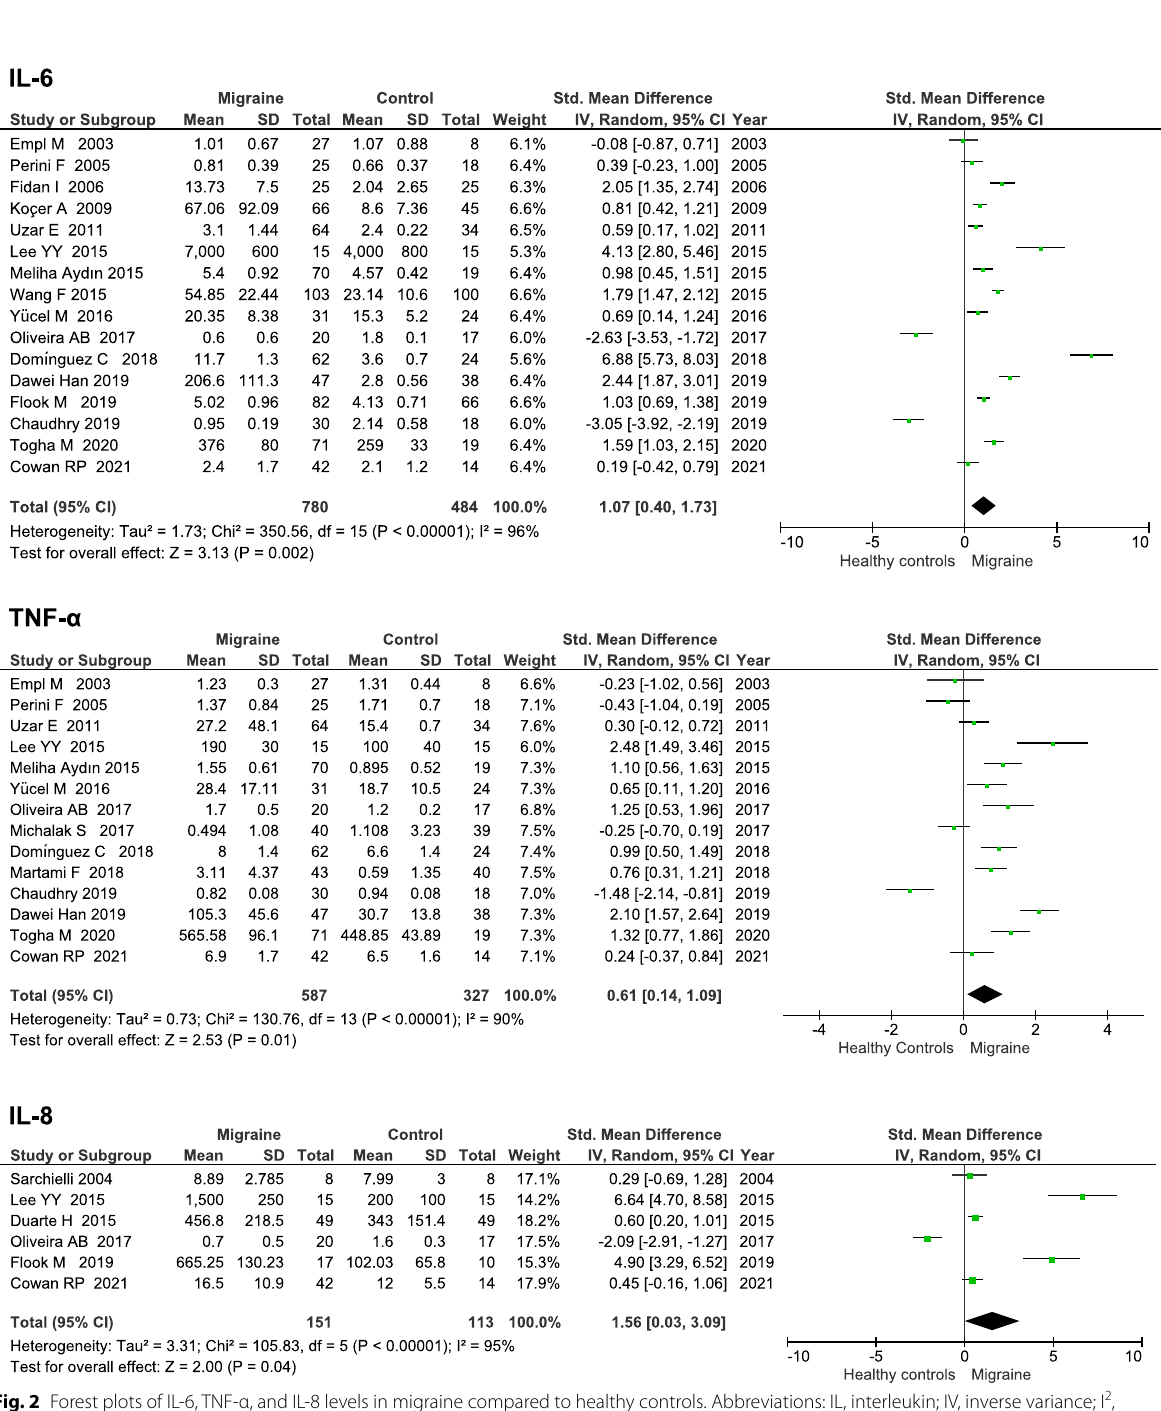
Fig. 2 Forest plots of IL-6, TNF-α, and IL-8 levels in migraine compared to healthy controls. Abbreviations: IL, interleukin; IV, inverse variance; I 2 , measure of heterogeneity; SD, standard deviation; TNF-α, tumour necrosis factor